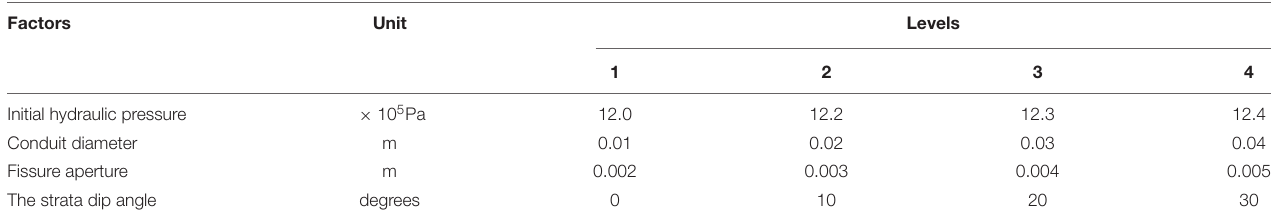
TABLE 2 | The effect factors and levels of the orthogonal array design. Factors